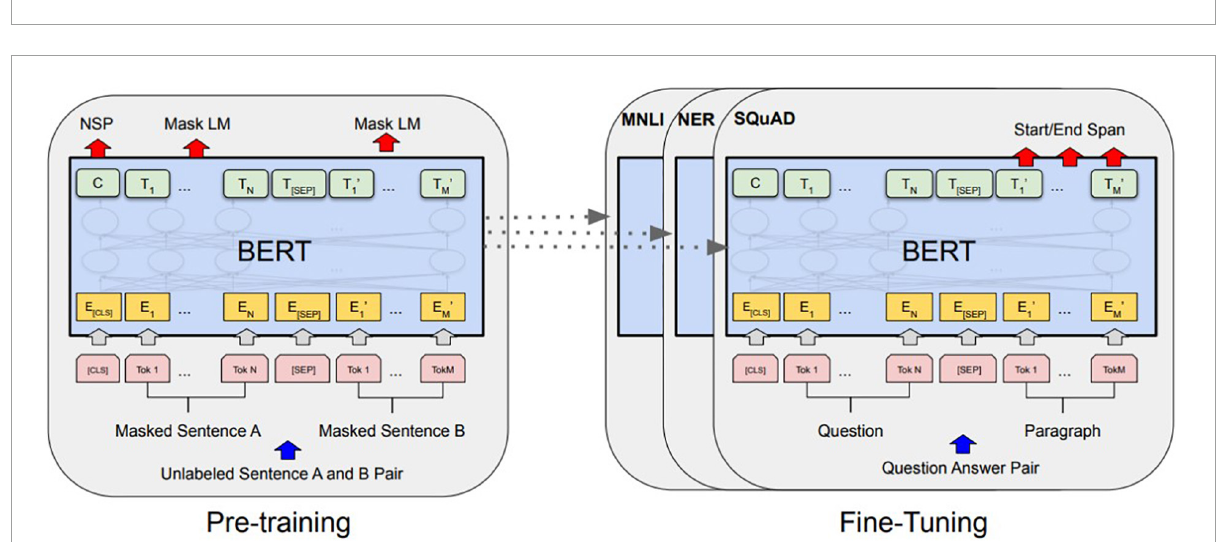
FIGURE5 BERT pre-training and fine-tuning procedures.